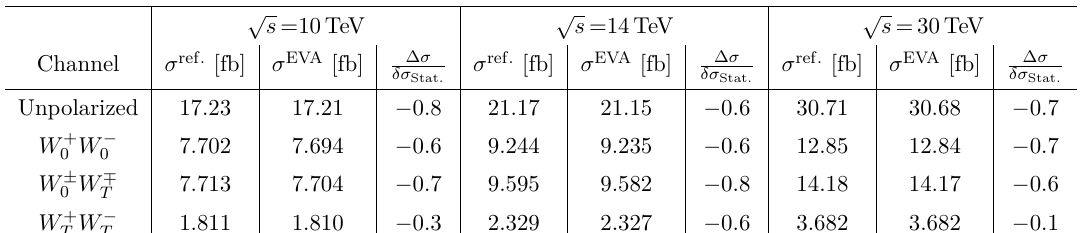
, (third row) W ± , W − W ∓ 0 0 0 T